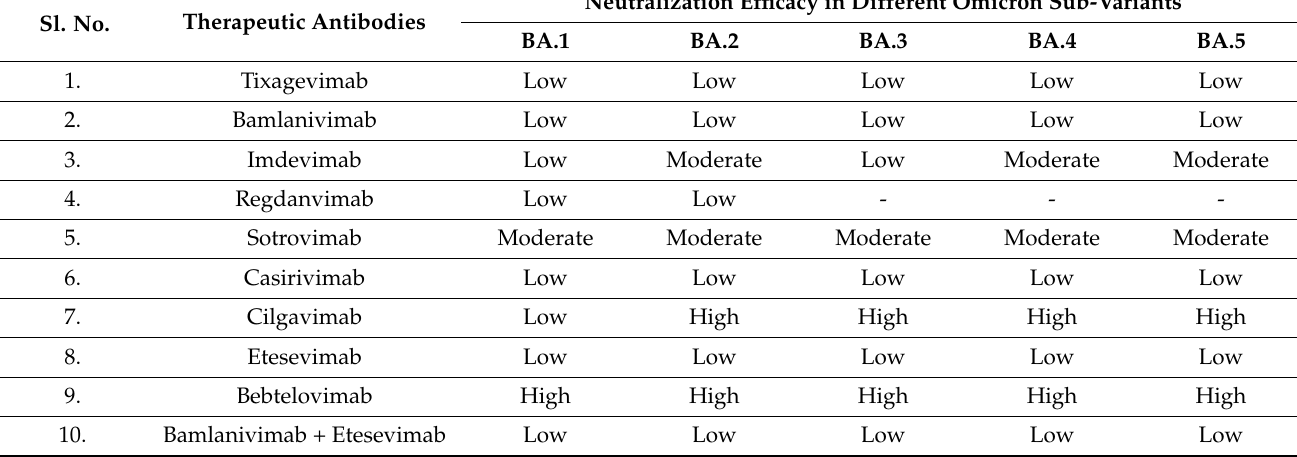
Table 3. The efficiency of the antibodies effective against Omicron and its sub-variants. Neutralization Efficacy in Different Omicron Sl. No. Therapeutic Antibodies